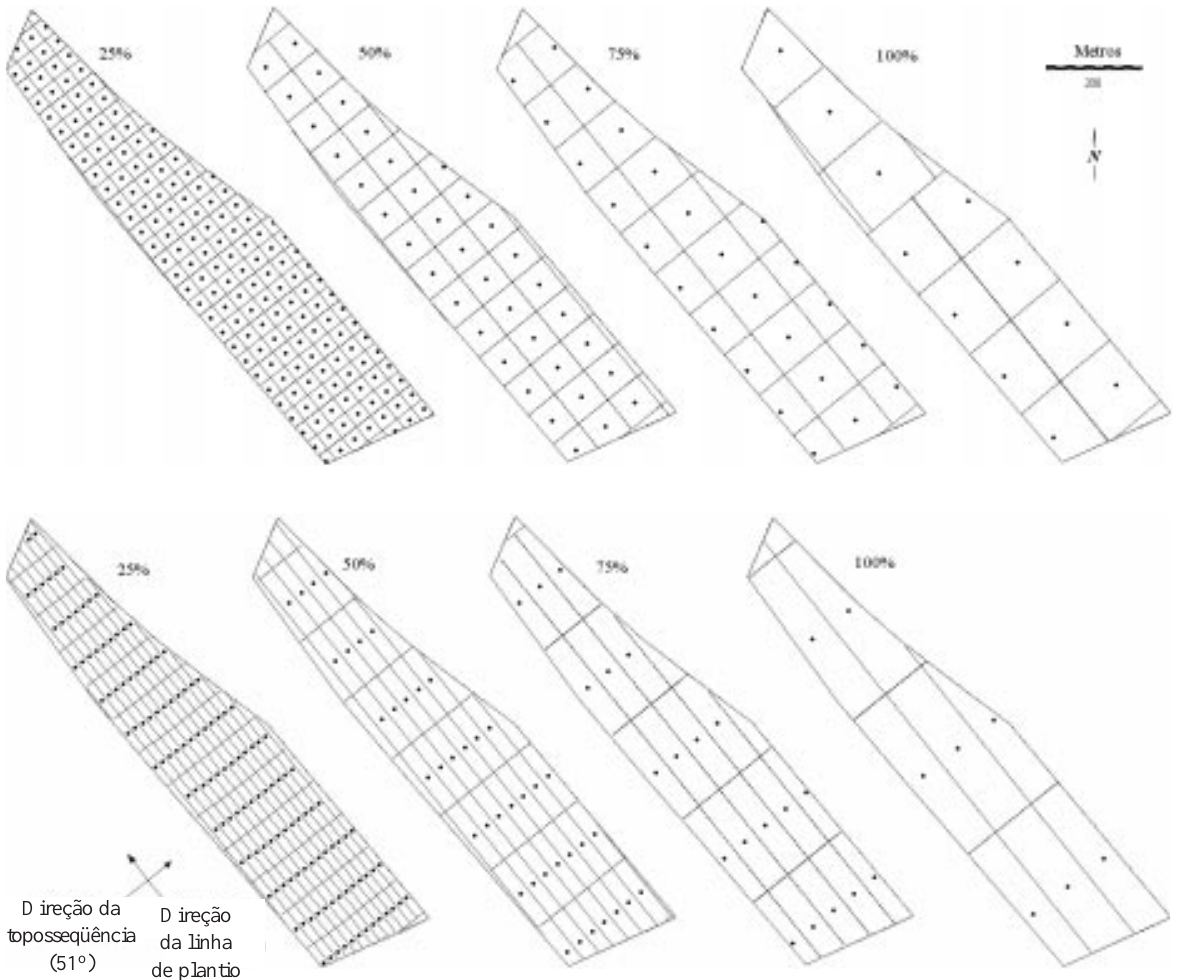
Figura 5. Proposições de amostragem sob níveis de percentagem da variância da estimativa, segundo análise isotrópica (conjunto superior) e anisotrópica